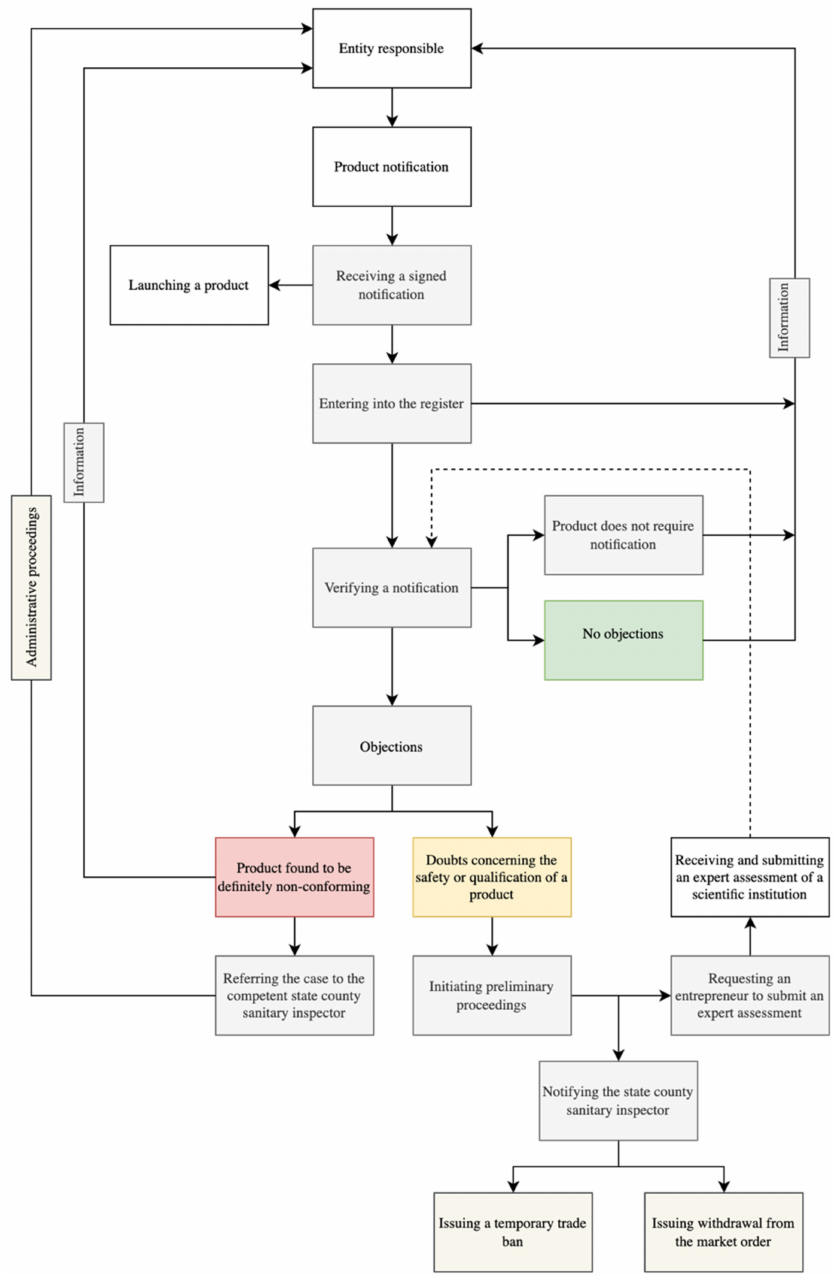
Figure 2. Scheme of a notification procedure applicable to intention to launch a functional product in Poland. The white boxes represent the actions of the reporting entity, the gray boxes are the actions of the Chief Sanitary Inspector, and the beige boxes are the actions of the state county sanitary